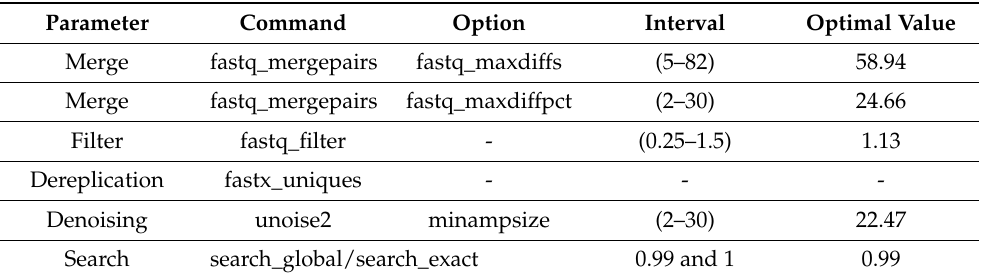
Table 1. Parameters, commands, and options used in the Usearch pipeline, as well as defined interval values and final optimal values selected throughout Bayesian optimization. Only WT Illumina MiSeq pairs from the α -gliadin amplicons were used to maximize the number of reads matched to the α -gliadins database. WT: wild type.